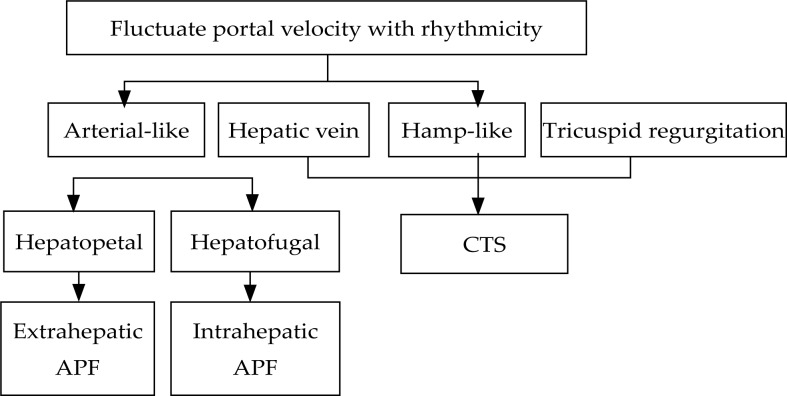
Diagnostic procedure for APF or CTS.